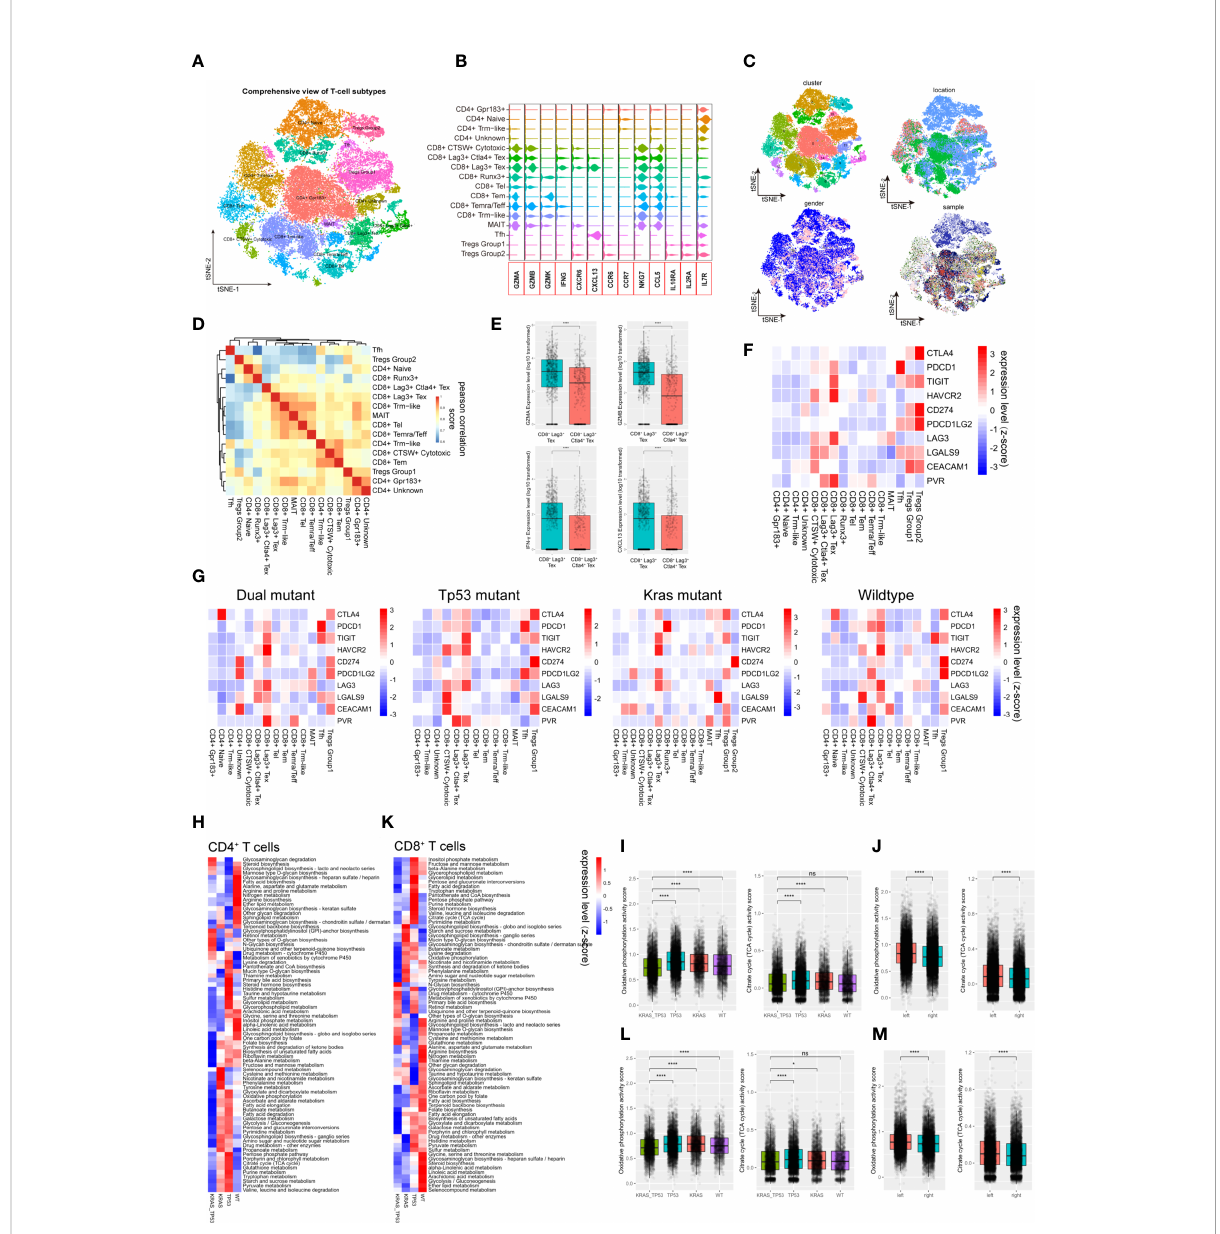
FIGURE 3 Tumor-in fi ltrating T cells exhibit molecular and metabolic heterogeneity according to tumor sideness and KRAS/TP53 mutation status. (A) The tSNE dimension reduction of all 71,946 T cells (including T cells derived from normal mucosa, tumor adjacent and tumor tissue), and visualization of the characteristics based on tSNE clusters. (B) The violin plot displayed the expression levels of key cytokines and receptors across various T cell types. (C) Visualization of the T-cell characteristics based on tSNE clusters, cells origin, tumor location and sample identity. (D) The heatmap showed spearman correlation between various cell subpopulations based on the top 500 genes with the highest standard deviation. (E) Boxplots presented the expression levels of GZMA, GZMB, IFN- g and CXCL13 in the two Tex (CD8 + LAG3 + Tex and CD8 + LAG3 + CTLA4 + Tex) groups. (F, G) The average expression levels of immune checkpoint molecules across various subtypes of T cells in (F) all tumor-in fi ltrating T cells, and (G) the expression according to KRAS/TP53 mutation status. The bar depicted the row-scaled average gene expression level. (H) The heatmap of signi fi cantly altered metabolic pathways (p < 0.001) of tumor-in fi ltrating CD4 + T cells based on KRAS/TP53 mutation status. The bar depicted the row-scaled pathway enrichment level. (I, J) The boxplots showed the levels of Oxidative phosphorylation (left) and Citrate cycle (TCA cycle) activity score of tumor-in fi ltrating CD4 + T cells according to (I) KRAS/TP53 mutation status and (J) tumor sideness. (K) The heatmap of signi fi cantly altered metabolic pathways (p < 0.001) of tumor-in fi ltrating CD8 + T cells based on KRAS/TP53 mutation status. The bar represented the row-scaled pathway enrichment level. (L, M) The boxplots presented the levels of Oxidative phosphorylation (left) and Citrate cycle (TCA cycle) activity score of tumor-in fi ltrating CD4 + T cells based on (L) KRAS/TP53 mutation status and (M) tumor sideness. ns, not signi fi cant; *p < 0.05; ****p <